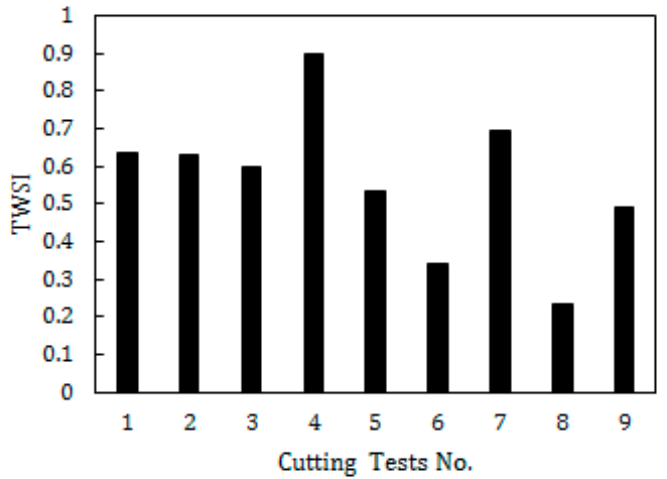
Figure 6. The sustainability assessment results.